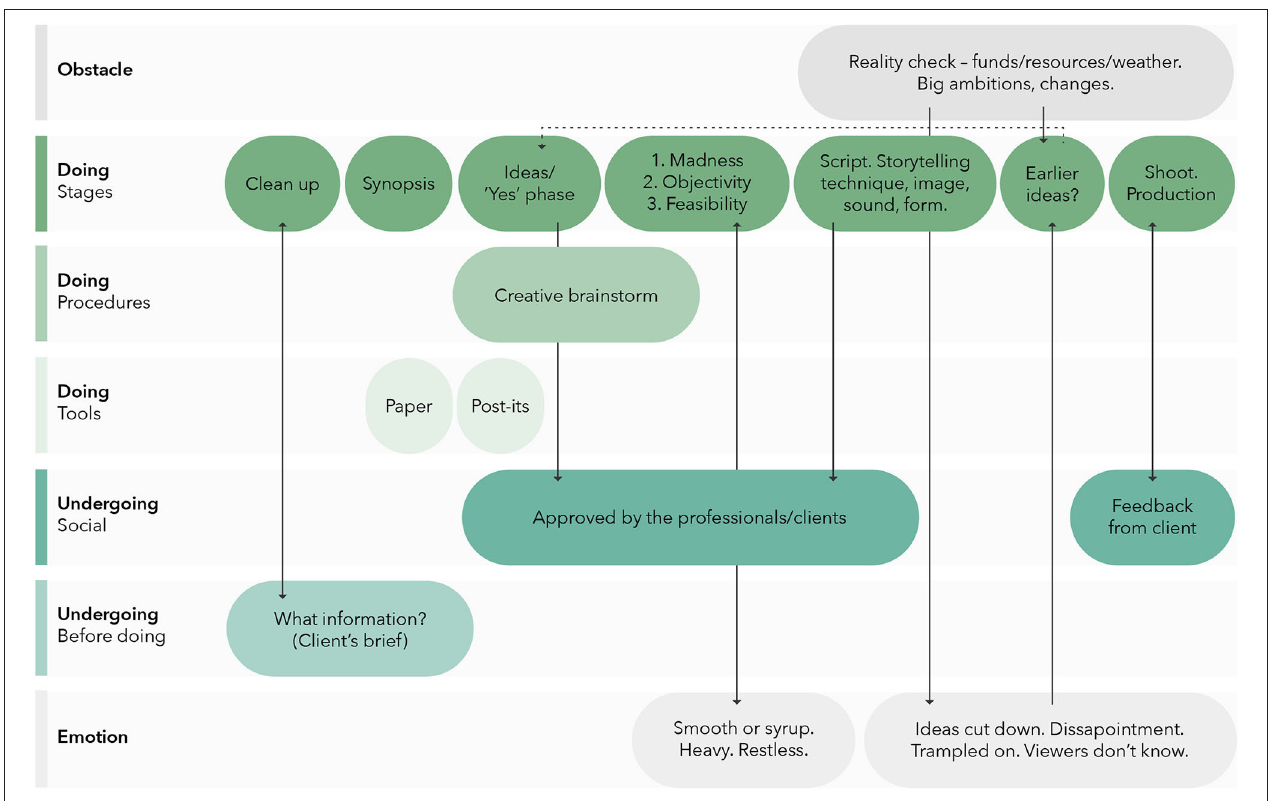
FIGURE 4 | A flow chart representation of creative activity as explained by film and science communication professionals.